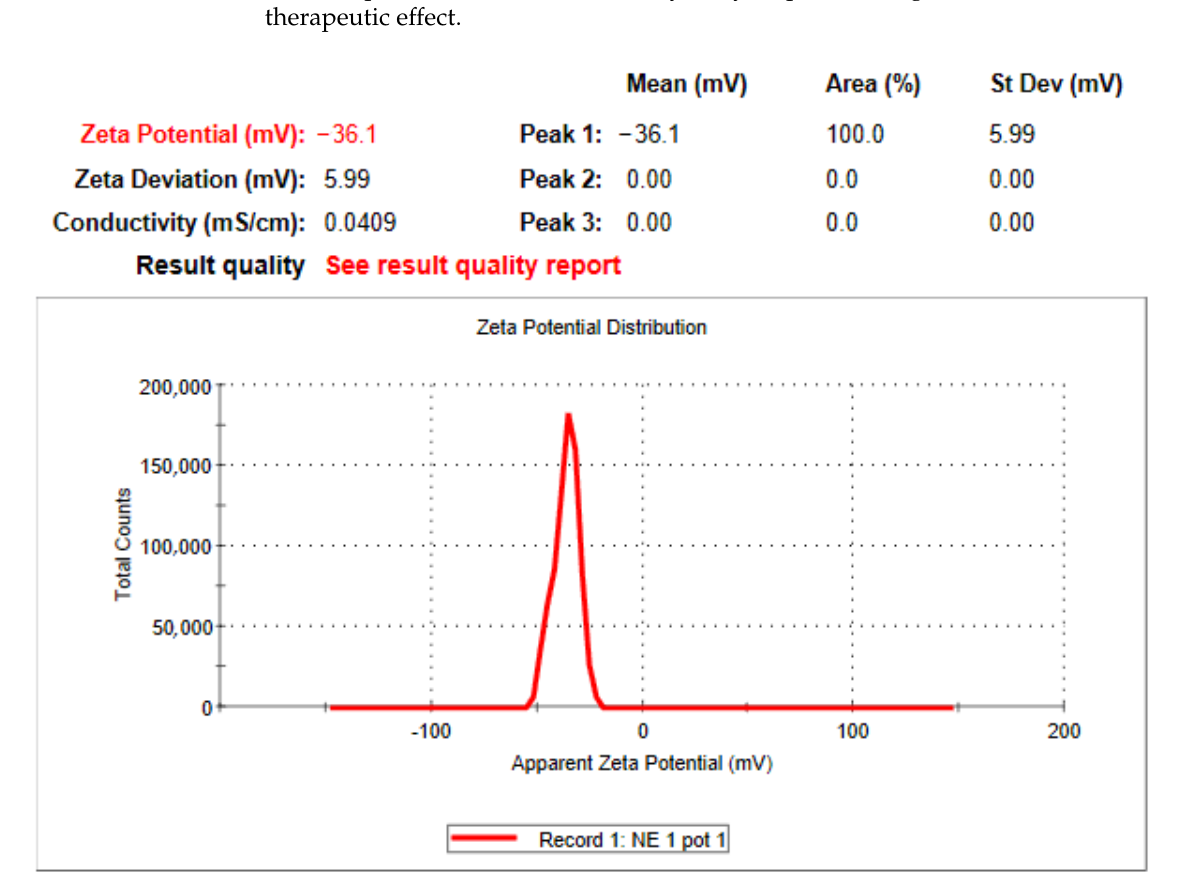
Figure 4. Zeta potential of optimized quercetin-loaded nanoemulsion.